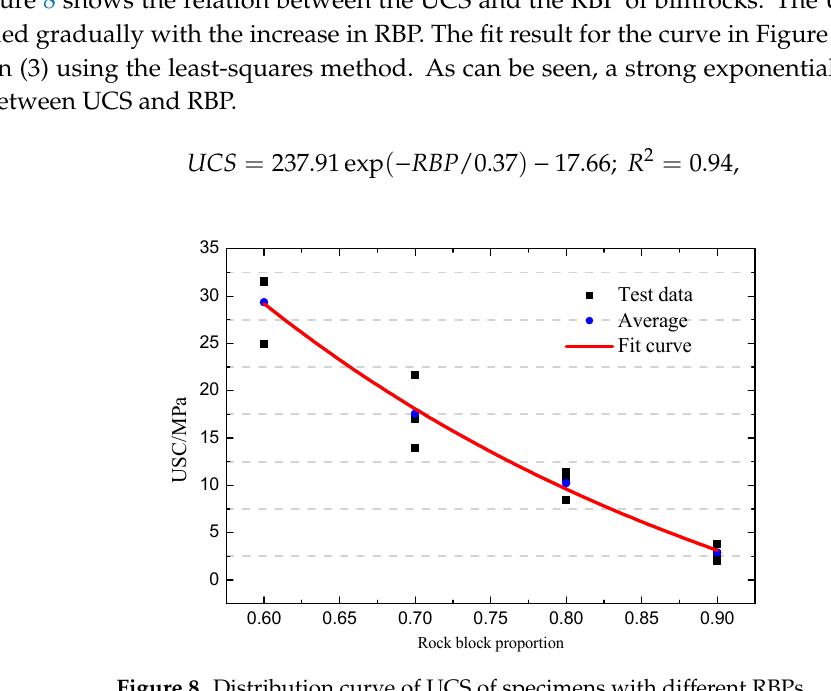
Figure 8. Distribution curve of UCS of specimens with different RBPs. Table 1. The UCS values for the bimrocks with the various RBP.